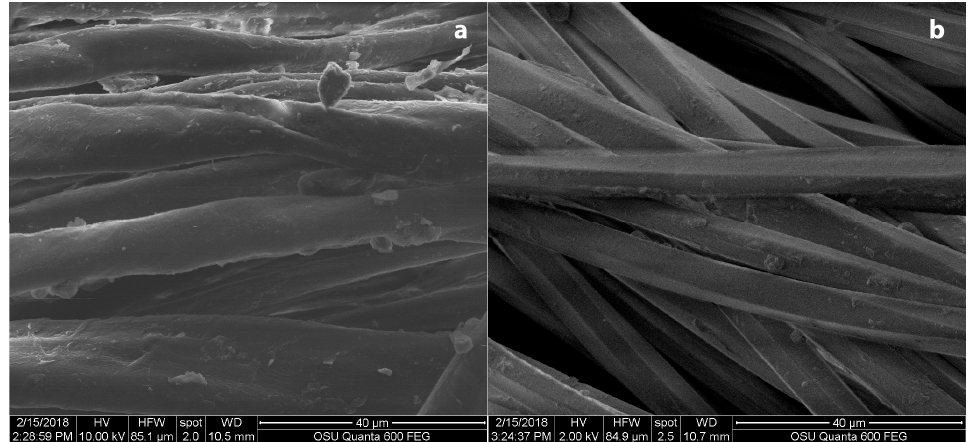
Figure 2. Undyed controls for ( a ) cotton; ( b ) polyester, showing differences in surface texture. Images taken with a FEI Quanta 600.